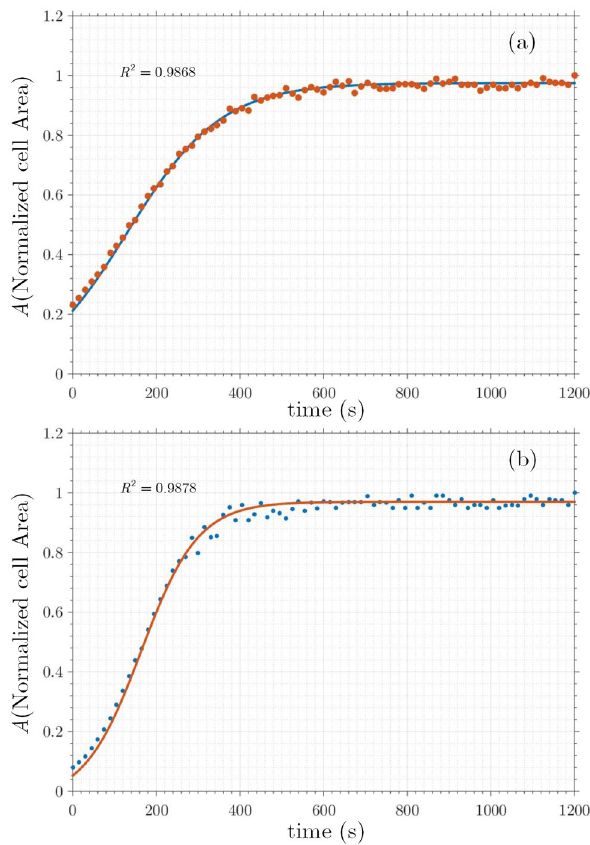
Figure 8. Cell normalized area vs. time. From which adhesion coefficient and elasticity were inferred ( a ) after treatment, ( b ) before treatment.